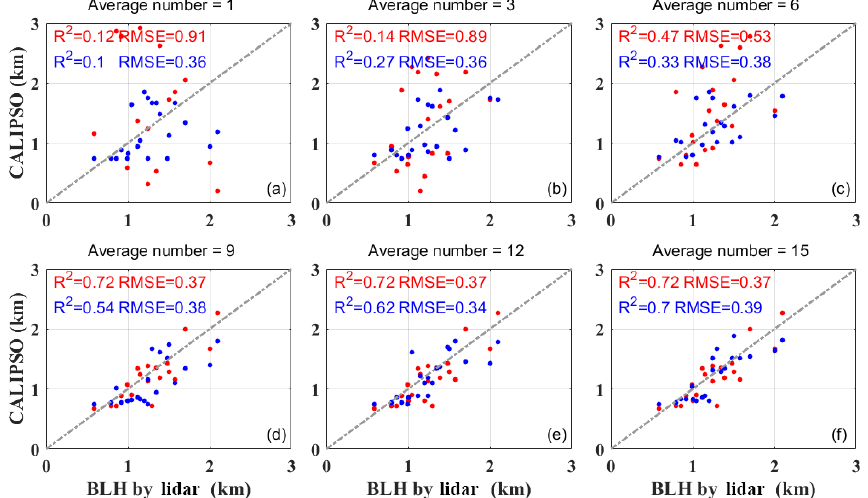
Figure 9. Correlation of BLH derived from CALIPSO and ground-based lidar under the horizontal smoothing number of (a) 1, (b) 3, (c) 6, (d) 9, (e) 12 and (f) 15. The red and blue points represent the BLH calculated by GDM algorithm and MSD method,